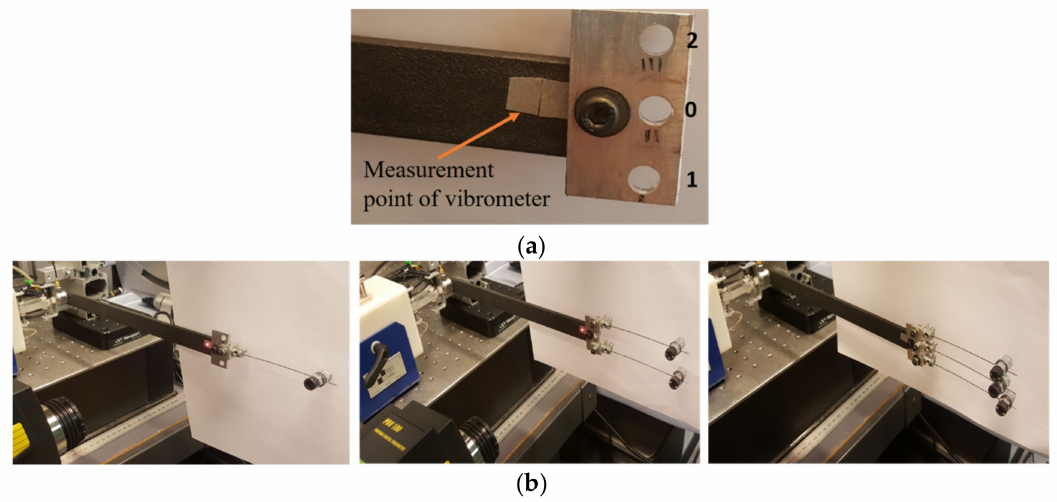
Figure 4. ( a ) TMD holding piece; ( b ) one, two, and three TMDs attached to the experimental arm. IMU of Hikob Fox type is added to the experimental arm to obtain the acceleration and angular velocity signals. IMU is added at the position of the measurement point of the vibrometer. The measurements of the full-scale ranges of the accelerometer and gyrometer are ± 2 g and ± 500 ◦ /s with a corresponding resolution of 12 mg and 17.5 m ◦ /s, respectively. Measurements using IMU are recorded for 60 s, with a sampling frequency of 1344 Hz for the acceleration and 800 Hz for the angular velocity, which are downsampled by